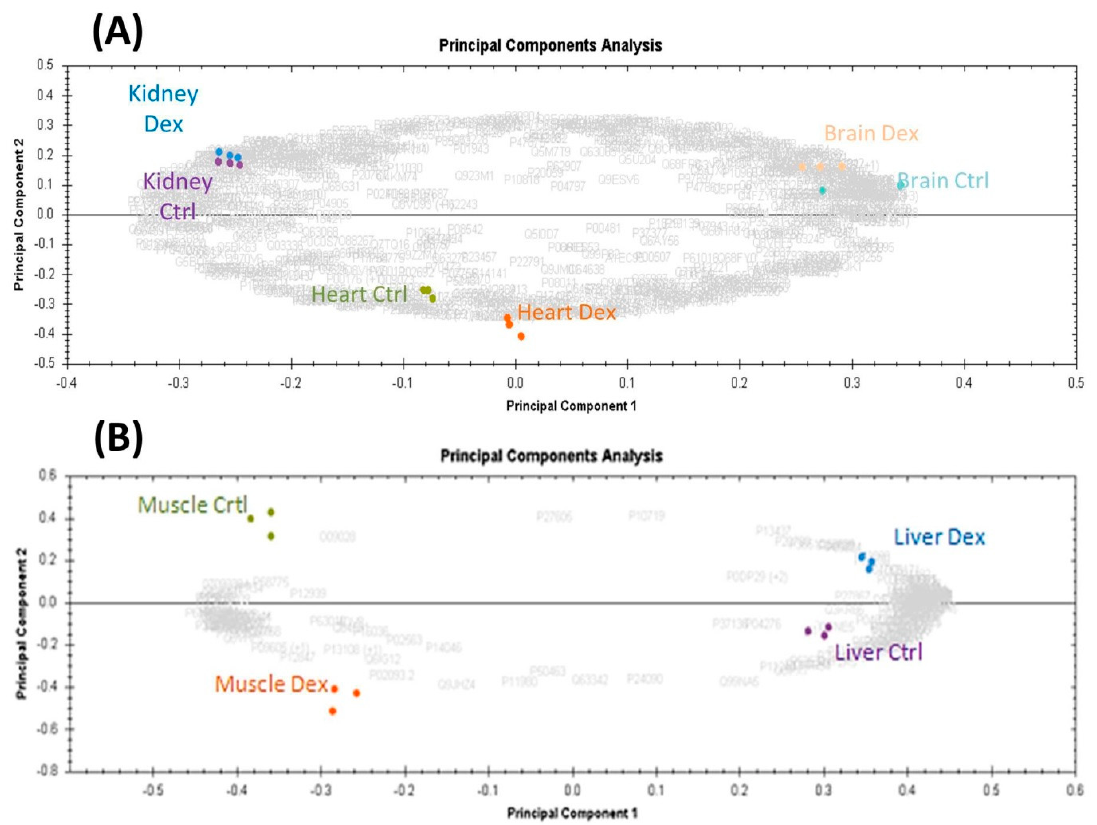
Figure 2. ( A ) Principal component analysis (PCA) plot of brain, heart, and kidney tissue samples using the protein expression dataset. Shown are the brain (orange, blue), heart (orange, green), and kidney (violet, purple) tissues between Dex-treated and control rats, respectively. ( B ) PCA plot of liver (blue, purple) and muscle (orange, green) tissues between Dex-treated and control rats, respectively. The separation seen between the treated and the control groups in each tissue sample represents the biological di ff erences due to the prolonged Dex treatment. The letters in grey color in the background represent the accession numbers of all the implicated proteins in the analysis. (Data were generated using Progenesis QI for proteomics (ProgenesisQIfp version 2.0.5387, Nonlinear Dynamics/Waters.). The separation between the Dex-treated and control samples in different tissues was apparent in all the morphologically altered organs, where the cutoff values to filter these proteins were p -values < 0.05, and fold change > 1.5. The number of relatively expressed proteins identified between the Dex-treated group compared to the control in the five different organs and the proteins in common between them are